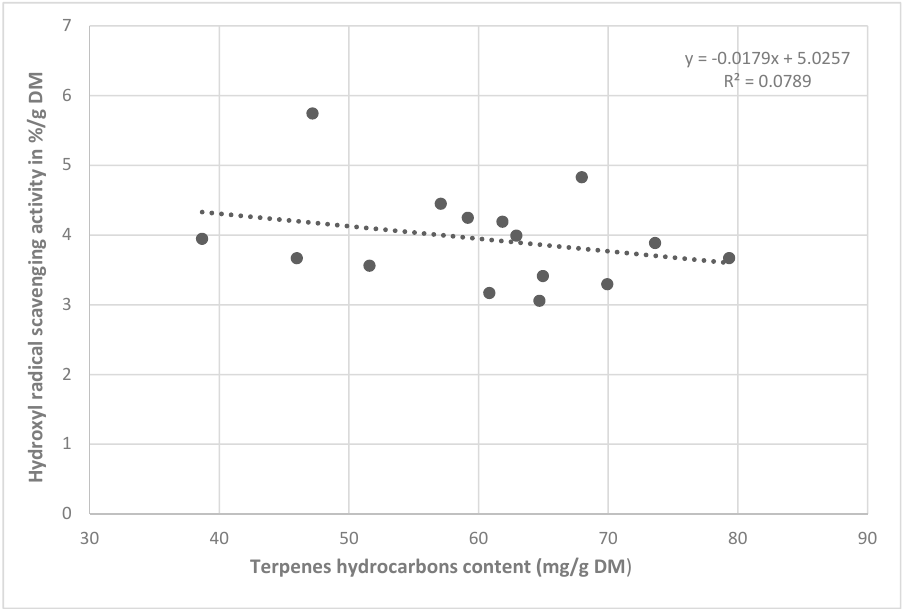
Figure 3. Correlation between antioxidant activity and terpene content in CB extracts.